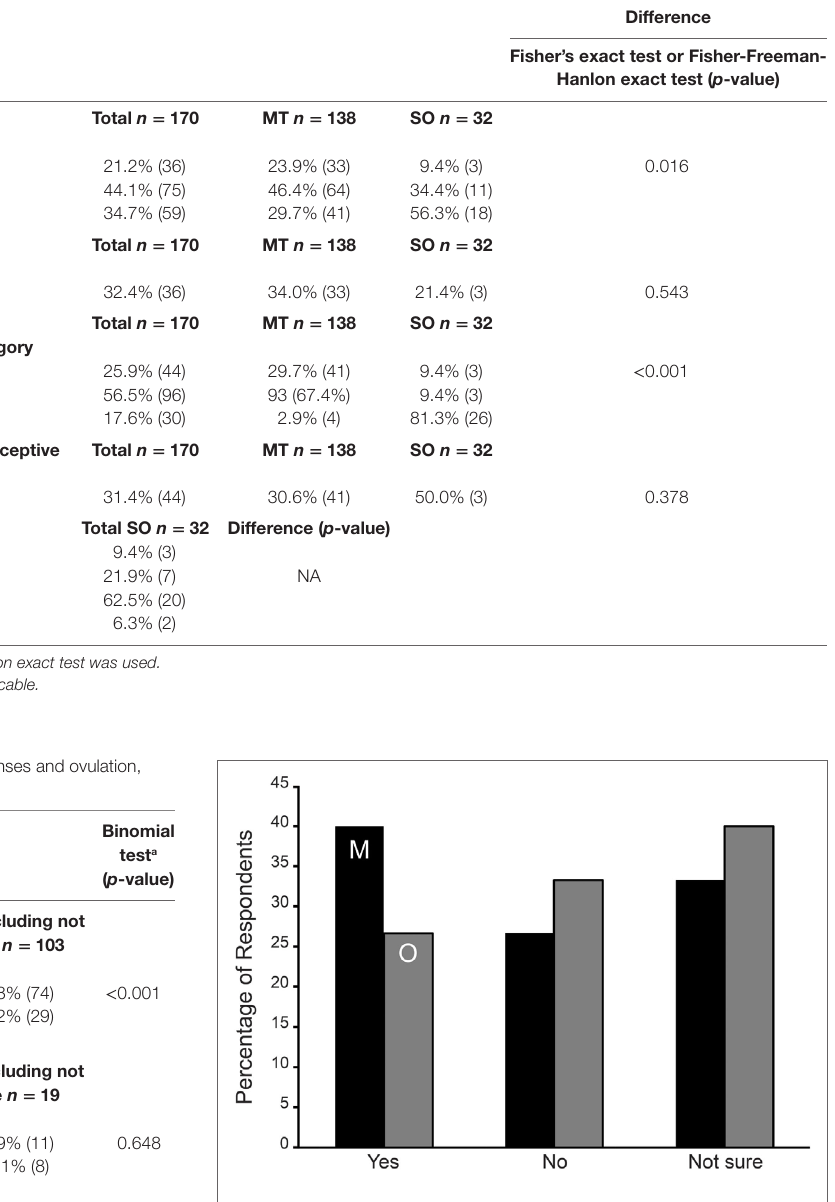
FigUre 1 | Symptom aggravation during menses (M—black bars) and mid-cycle around ovulation (O—gray bars) in Spontaneous/Other (SO) group expressed as the percentage of respondents. No statistically significant difference was observed among the SO group reporting an aggravation of symptoms during menses or ovulation.